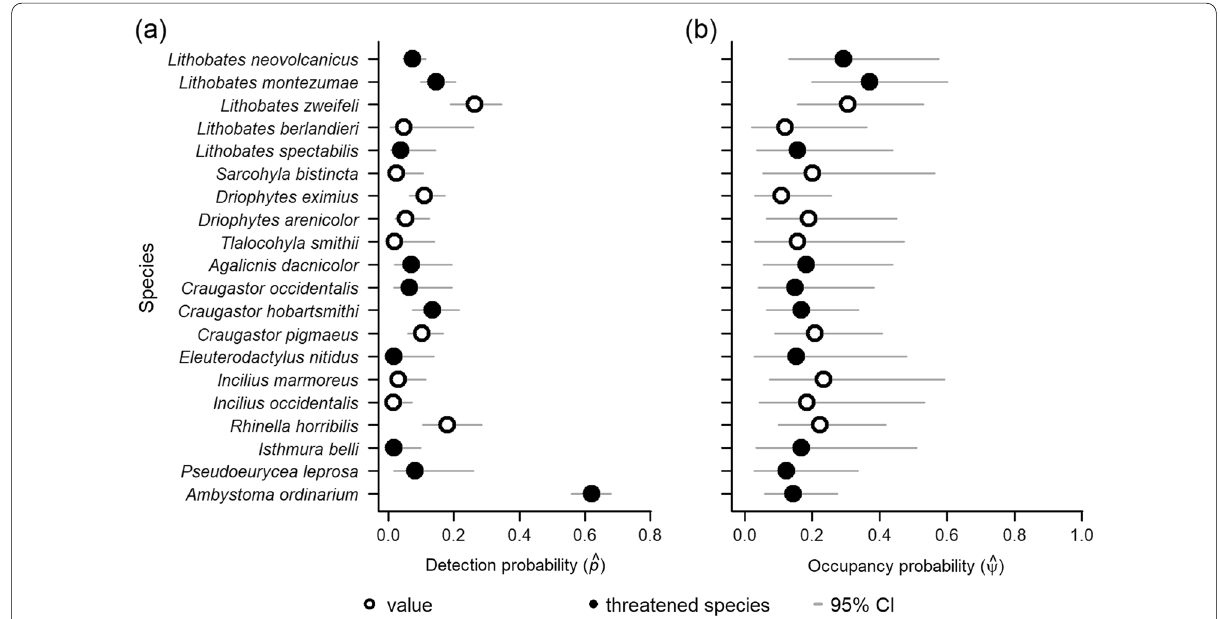
Fig. 2 Mean probability estimated of a detection and b occupancy for each amphibian species in all sampling